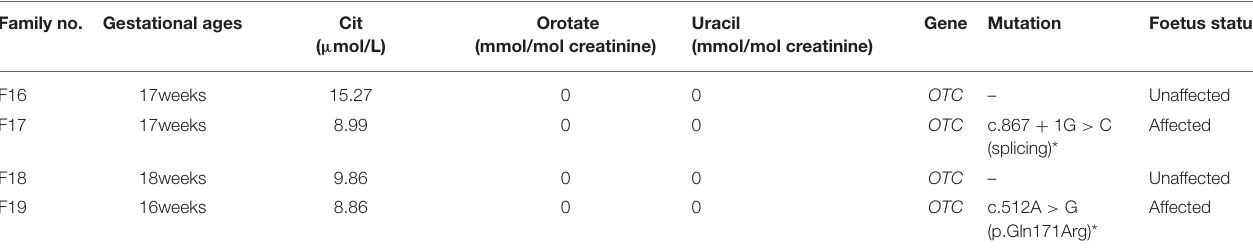
TABLE 3 | The characteristic metabolites levels and DNA sequencing results in the amniotic fluid samples of four foetuses from OTCD families referred. Family no. Gestational